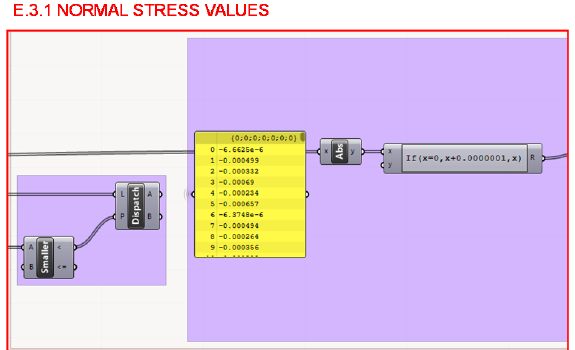
Figure 31. Programming structure definition to extract the values of the normals of the bars in absolute value.